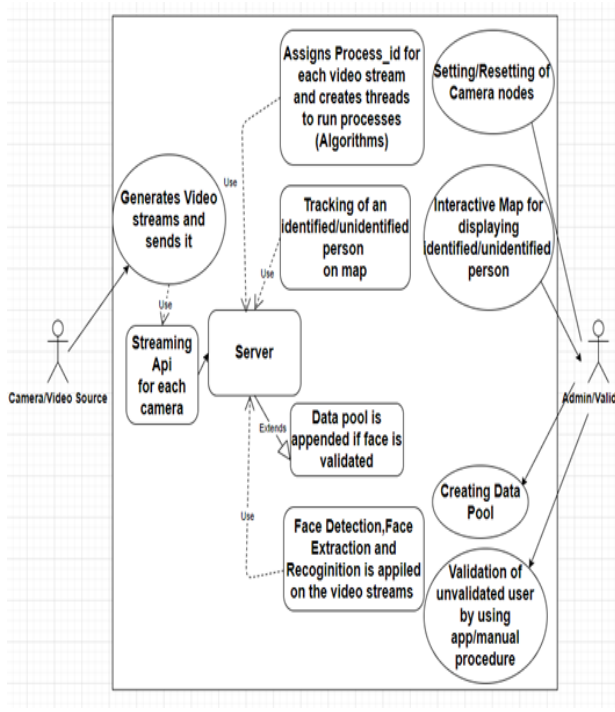
fig 3: interaction between user and admin In an environment as specified in the Introduction, various video streams are given to System (Server). The Superordinate object initiates a camera object for each video stream, prioritizing the gate video stream object.